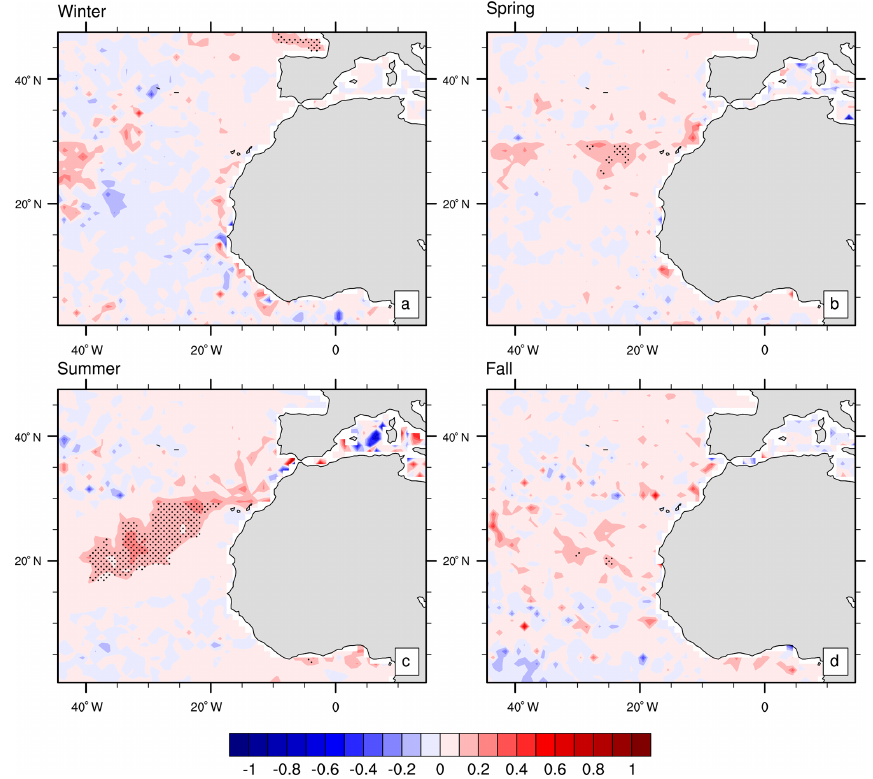
Figure 11. The sensitivity of cloud fraction to a relative change in aerosol index for (a) winter, (b) spring, (c) summer, and (d) fall. Dots represent the significance at 95% confidence